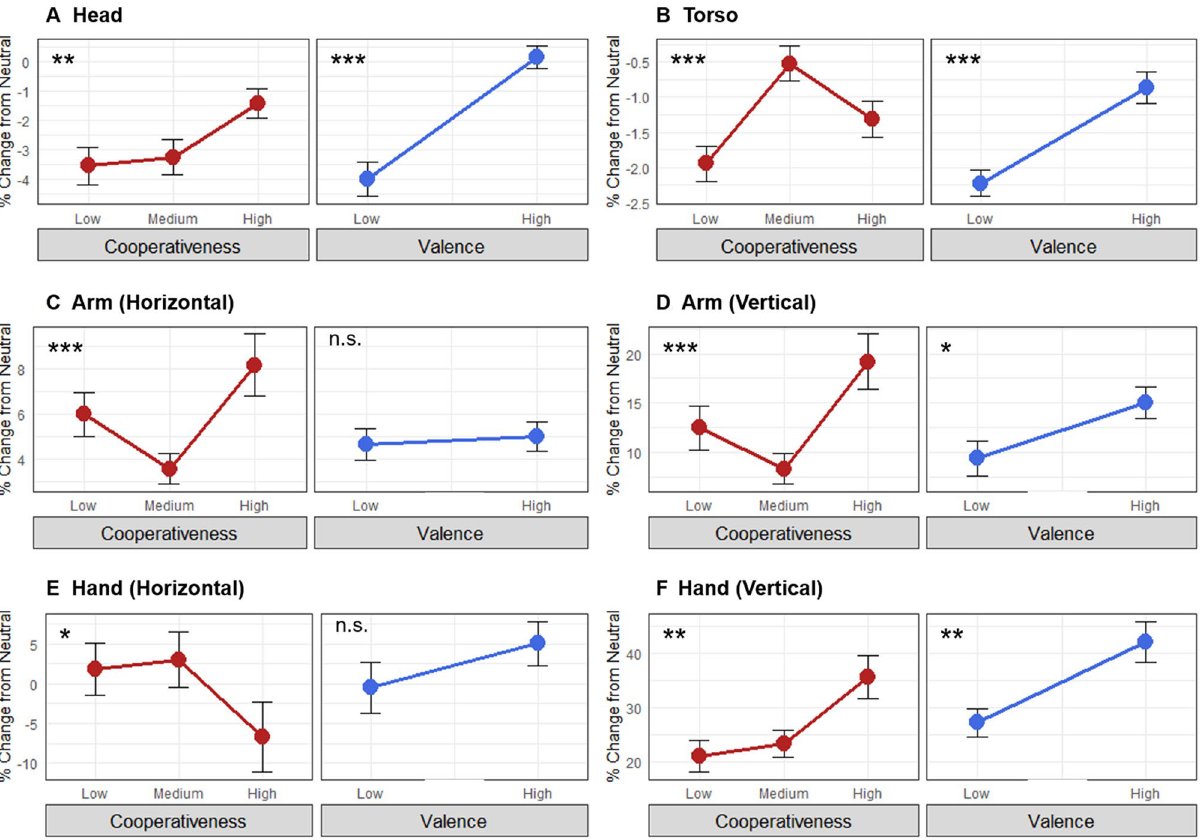
Figure 4. Body effects of character cooperativeness and emotional valence . The figure shows the effect of character cooperativeness (left panels in red) and emotional valence (right panels in blue) on the parameter means of the 6 body segments. Values for each segment are the percent change relative to the neutral emotion condition, which corrects for the diversity of body dimensions across participants. Error bars indicate the standard error of the mean. Significance values are from a liner mixed-effects regression model for the main effects of character dimensions. * p < .05, ** p < .01, and *** p < .001 after Bonferroni correction, n.s., not significant. See Table 1 for the full character descriptions and Table 2 for the full emotion